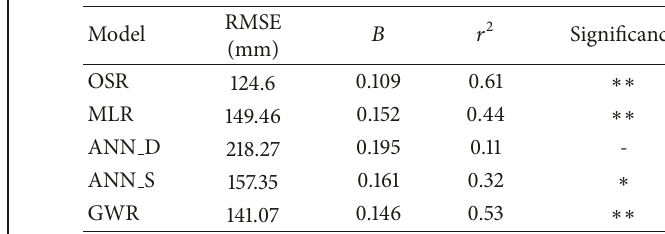
Table 3: A comparison of results from the different downscaling